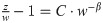
Topology of travel networks.Scaling between the driving distance (z) and geodesic distance (w) on different travel networks. The curves suggest the zw-1=C·w-β relation, with the parameters given in Table 1. The figure illustrates also the topological structure of some human transportation networks used in the present study (see the Methods section). Please note the logarithmic axes.